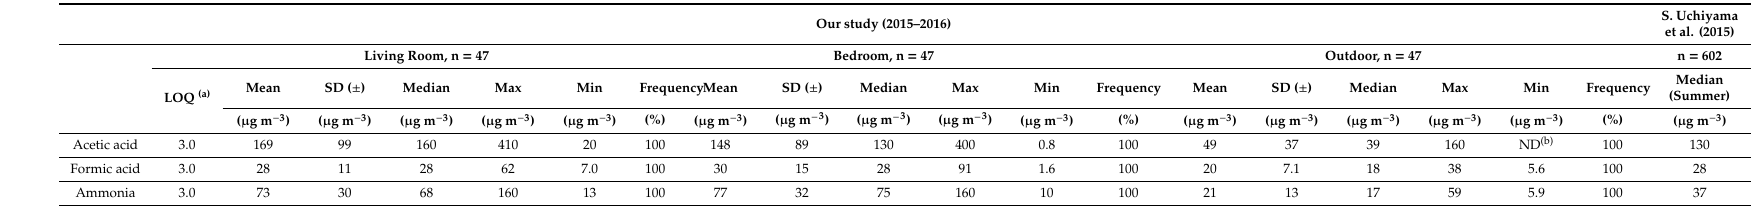
Table 2. Concentrations and frequencies of acetic acid and formic acid